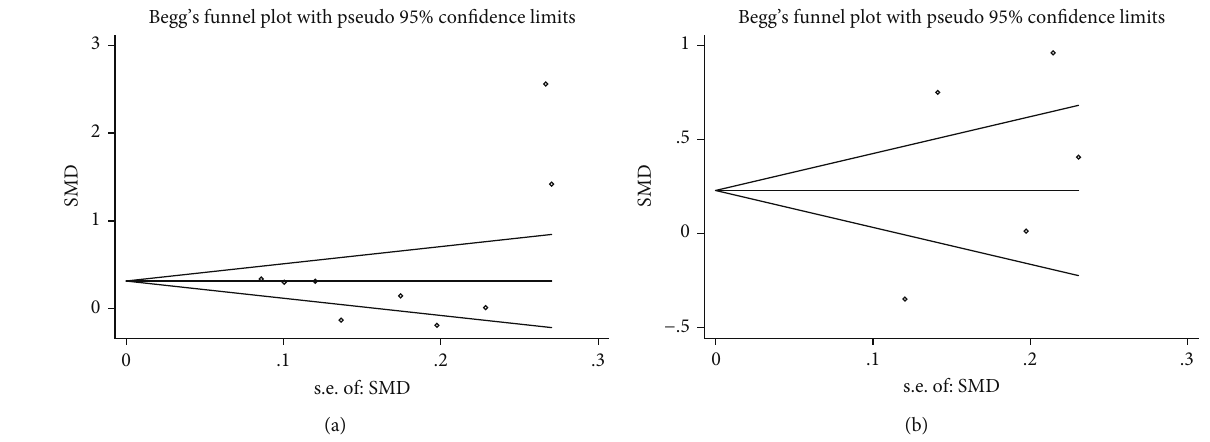
Figure 4: Begg ’ s funnel plot for assessing publication bias. (a) Begg ’ s funnel plot for assessing publication bias for PLR. (b) Begg ’ s funnel plot for evaluating publication bias for